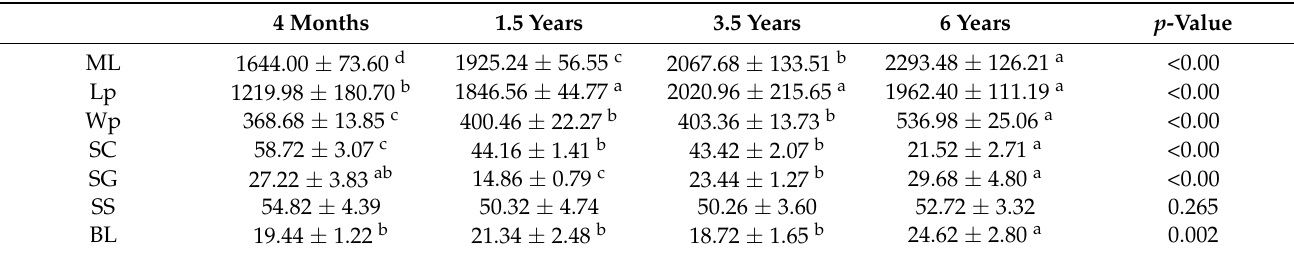
Table 2. Structure of rumen epithelium at different ages ( µ m).